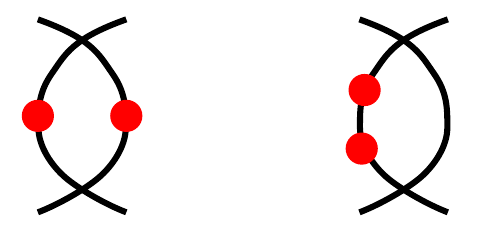
Figure 1 . The split types of an I 2 -(cid:12)bre by two sections (red dots): (01) on the left and (0 j 1) on the